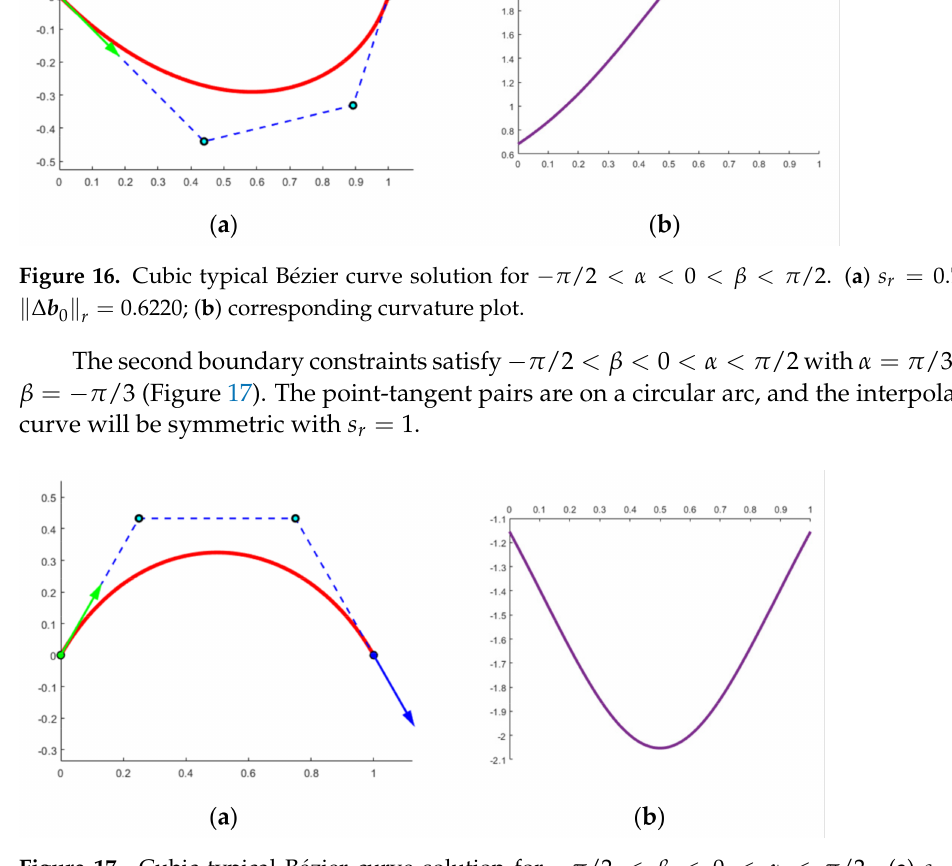
Figure 17. Cubic typical B é zier curve solution for − π /2 < β < 0 < α < π /2. ( a ) s r = 1, = 0.5; ( b ) corresponding curvature (cid:107) ∆ b (cid:107) 0 r